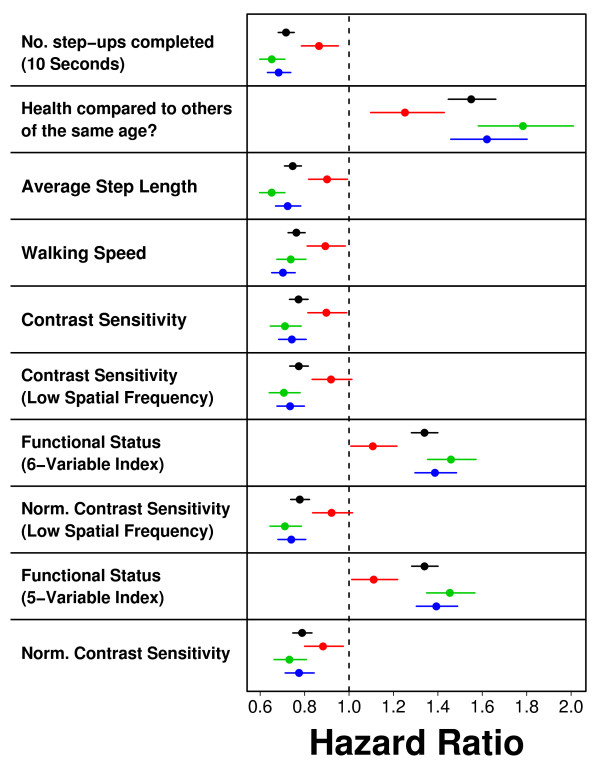
Hazard ratio estimates associated with best predictor variables. The hazard ratio was estimated using single-variable Cox PH models for each of the best predictor variables listed in Table 1. Each point represents a hazard ratio estimate, and horizontal lines correspond to 95% confidence intervals associated with this estimated value. Black points correspond to hazard ratios estimated using data from all n = 4097 subjects. Hazard ratios were separately estimated based upon the n = 467 cancer deaths (red points), the n = 426 cardiovascular deaths (green points), and the n = 586 non-accidental/non-cancer/non-cardiovascular deaths (blue points). Cause-specific ratios were calculated by treating the n deaths assigned to a specific cause as non-censored, with censoring applied to deaths assigned to any other cause.